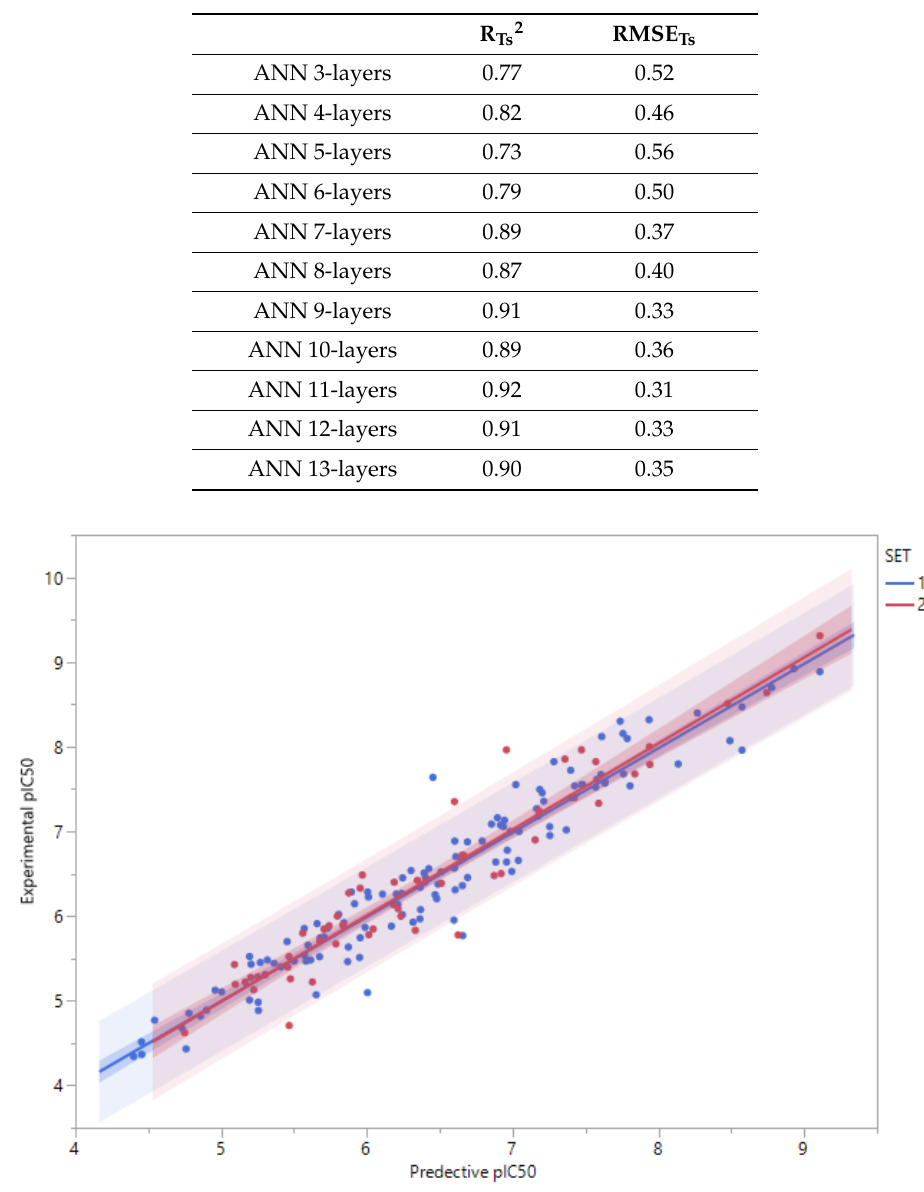
Figure 3. Correlation plots between predicted and experimental pIC 50 values for the training and the test sets derived using ANN methods. Training set (SET 1) molecules are represented by blue points and test set molecules (SET 2) are represented by red points. Table 4. Test-set values by using ANN